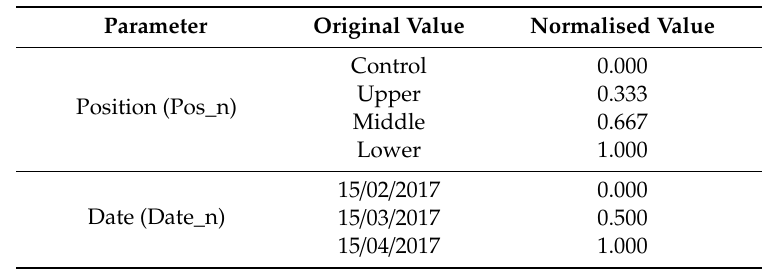
Table 3. Normalized position and date values for Multiple Linear Regression (MLR) (Pos_n and Date_n respectively). Parameter Original Value Normalised Value Control 0.000 Upper Position (Pos_n)